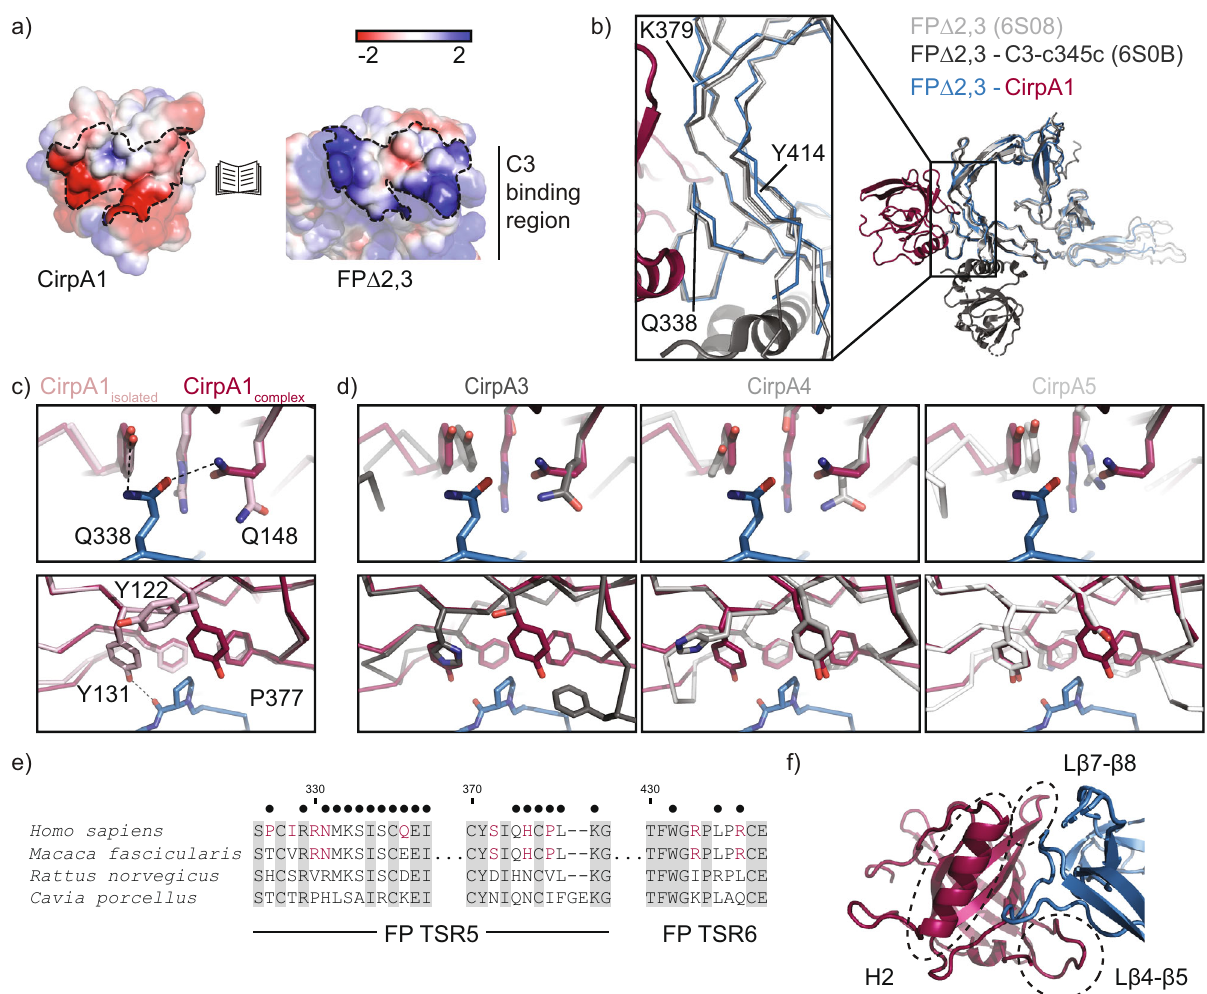
Fig. 4 Detailed analysis of the CirpA1- properdin interaction. a Positive (blue) and negative (red) electrostatic potential regions mapped onto the surface representations of CirpA1 and FP Δ 2,3 from the FP Δ 2,3-CirpA1 complex. Interface region area highlighted by dotted lines. b Overlay of structural models of isolated FP Δ 2,3 (PDB 6S08, light grey), FP Δ 2,3-C3-c345c (PDB 6S0B, dark grey) and FP Δ 2,3-CirpA1 (PDB 7B26, blue/magenta) aligned to properdin residues 320 – 440. Close up of CirpA1 interfacing region. c Structural changes in CirpA1 upon complex formation with FP Δ 2,3. d Superposition of structural models of CirpA3-5 (shades of grey) with the CirpA1- FP Δ 2,3 complex, view as in ( c ). e Multiple sequence alignment of properdin from species used in AP haemolysis assays in Fig. 2b, showing the regions interacting with CirpA1, red: residues unique to species inhibited by CirpA1, black dots: residues involved in the CirpA1- FP Δ 2,3 interface in the complex structure in Fig. 3e according to PISA analysis. f Close-up view of the CirpA1- FP Δ 2,3 interface, regions of high conformational variability between CirpA homologs as identi fi ed in Fig. 2d highlighted with dashed